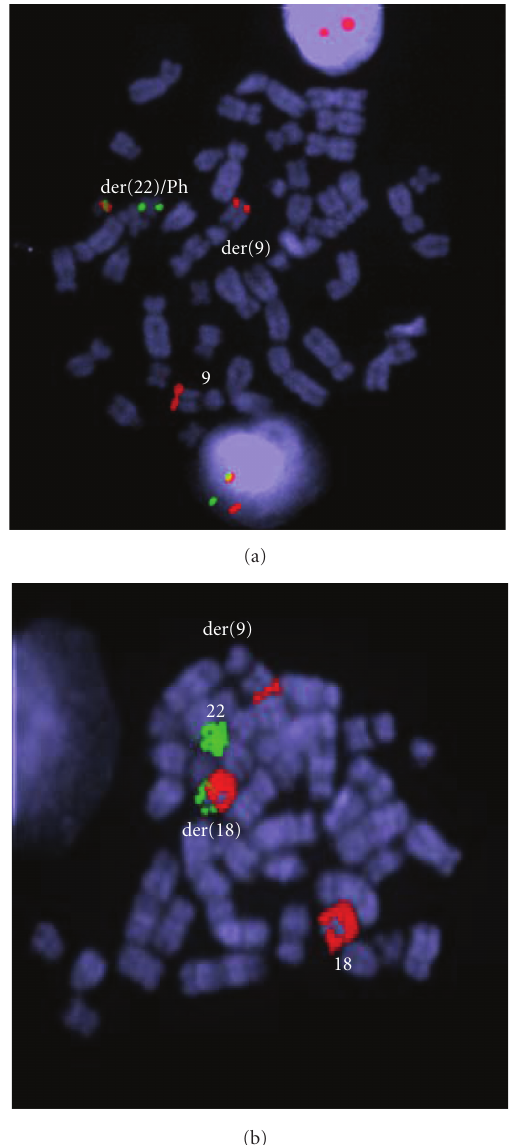
Figure 2: FISH analysis demonstrating the presence of t(9;18; 22)(q34;p11;q11). (a) Using the bcr/abl (ES) probe, we observed a red signal on the normal chromosome 9, a smaller red signal re- tained on the der(9), a green signal on the normal chromosome der(22), and a yellow fusion signal on the der(22). Using 4,6- diamidino-2-phenylindol (DAPI) counterstain, a G-banding-like pattern of the same metaphase can be obtained. (b) Fluorescence in situ hybridization with the use of whole chromosome painting probes